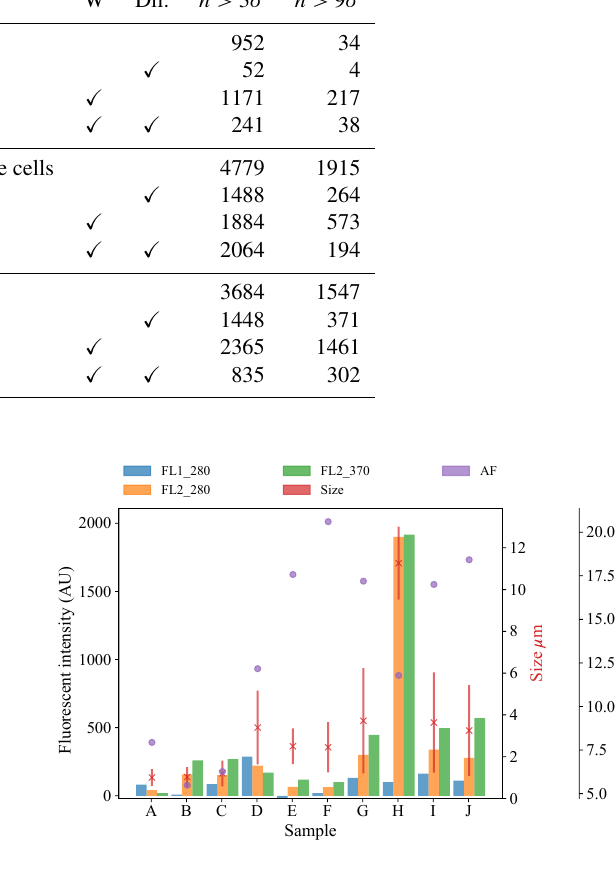
Figure 7. Average fluorescent characteristics for the different aerosol samples collected in 2014. The error bars in red indicate a range of ± 1 σ for each